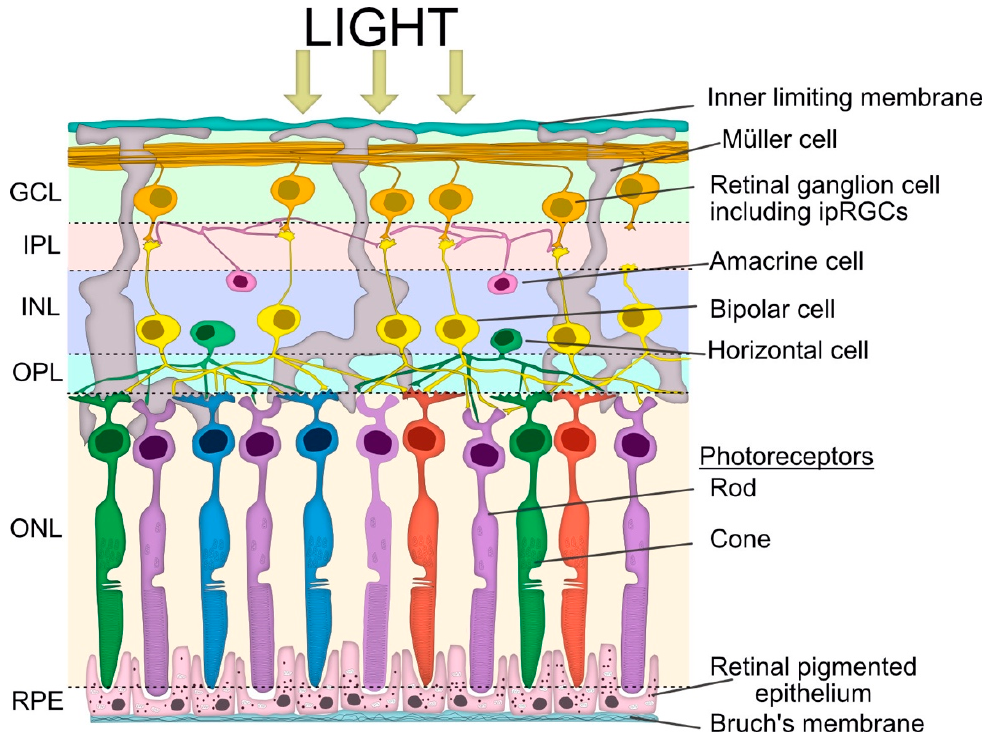
Simplified schematic view of retinal layers involved in the pupillary light reflex. Vertical signalling pathways in the retina are composed of the photoreceptors (rod and cone cells), bipolar cells and retinal ganglion cells (RGC), including intrinsically photosensitive retinal ganglion cells (ipRGCs). There are also two lateral pathways comprised of horizontal cells in the outer plexiform layer (OPL) and the amacrine cells in the inner plexiform layer (IPL). These cells modulate the activity of other retinal cells in the vertical pathway. The somata of the neurons are in three cellular layers. The rod and cone cells are located in the outer nuclear layer (ONL), which is adjacent to the retinal pigment epithelium (RPE). The horizontal cell, bipolar cell and amacrine cell somas are located in the inner nuclear layer (INL), whilst the ganglion cell somata are located in the ganglion cell layer (GCL). The axon terminals of the bipolar cells stratify at different depths of the inner plexiform layer, which is subdivided into the OFF outer sublamina (where OFF bipolar cells terminate) and the ON inner sublamina (where ON bipolar cells terminate). There are also ON and OFF bands of melanopsin dendrites from the ipRGCs, but both lie outside of the ON and OFF cholinergic bands within the IPL. The bipolar cells are photoreceptor specific and the bipolar dendrites synapse exclusively with either rod or cone cells.